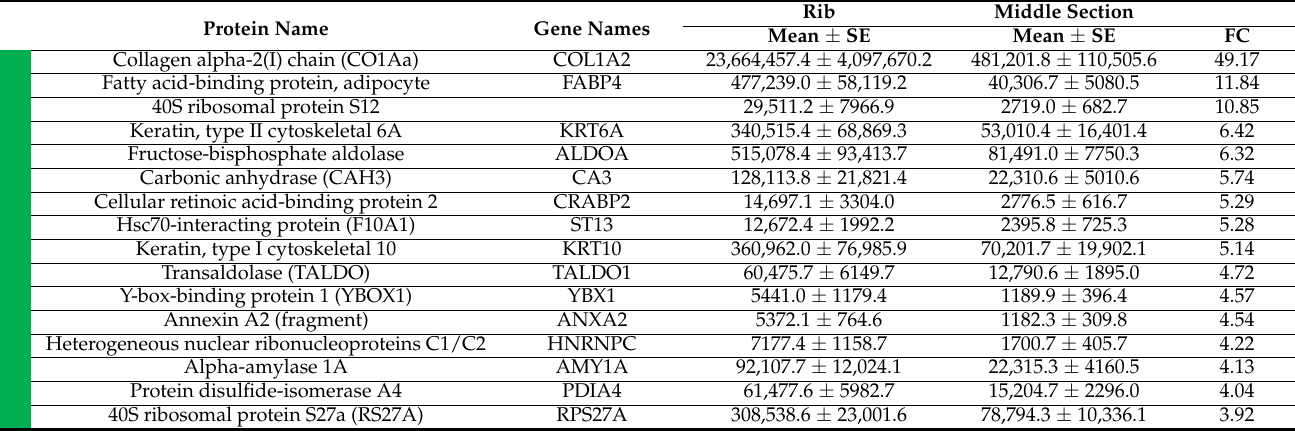
Table 2. List of differential abundant proteins (mean value ± standard error of mean) of the antler samples (middle section) of red deer ( Cervus elaphus ) from a native Iberian population compared to rib, gene names and fold change (FC) between both